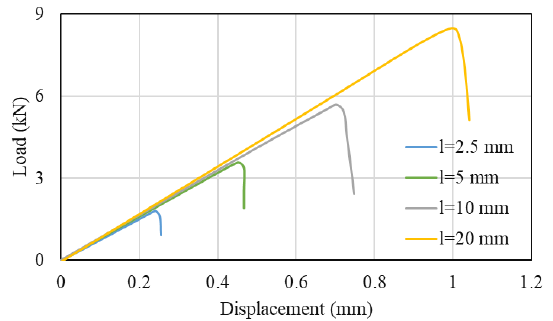
Figure 3. Load-displacement for different overlap length under tensile loading conditions. Adapted from [44].